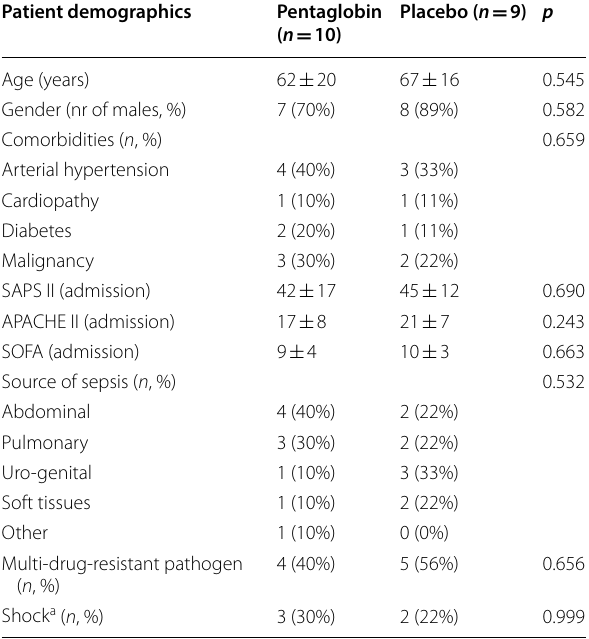
SAPS Simplified Acute Physiology Score, APACHE Acute Physiology and Chronic Health Evaluation, SOFA Sequential Organ Failure Assessment a Persistent arterial hypotension despite adequate fluid resuscitation and hyperlactatemia (lactate levels > 2 mmol/L)